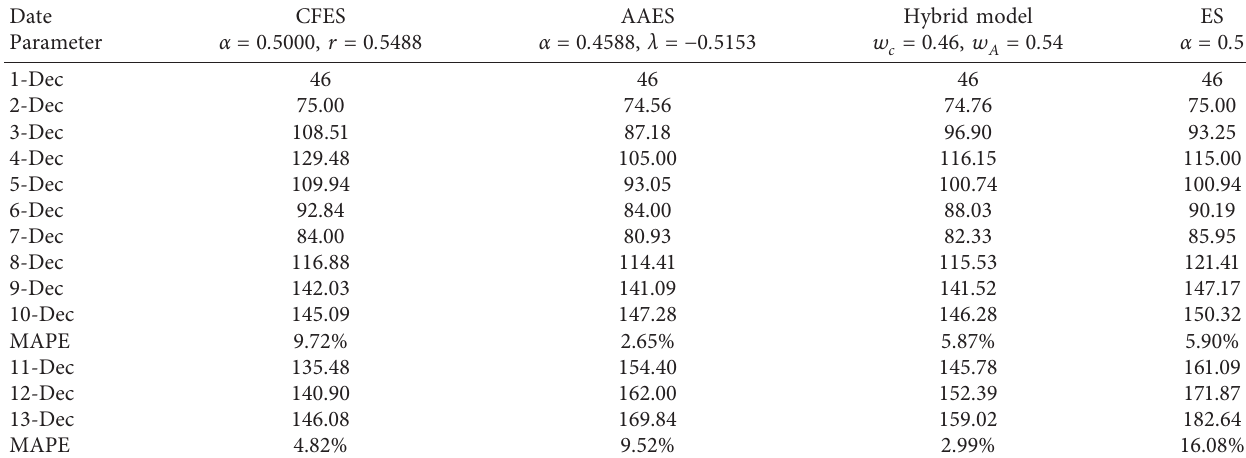
Table 4: The forecasting results of PM